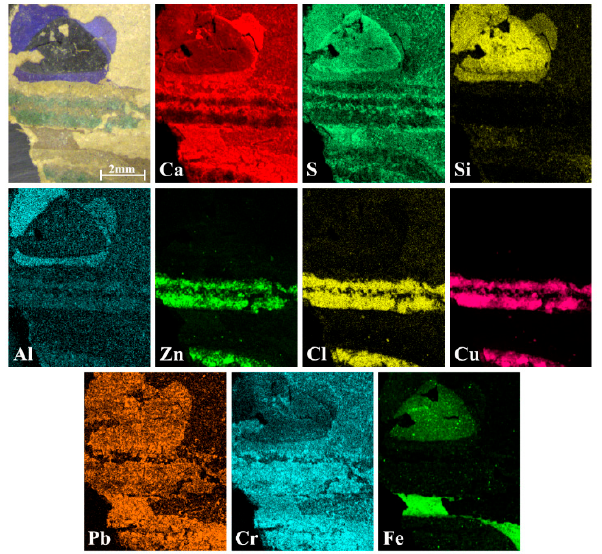
Figure 1. Micro-EDXRF maps from one of the decorative wallpaper samples (sample wp2).